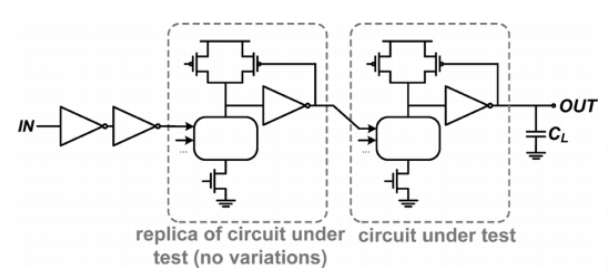
Figure 4. Circuit for evaluation of delay